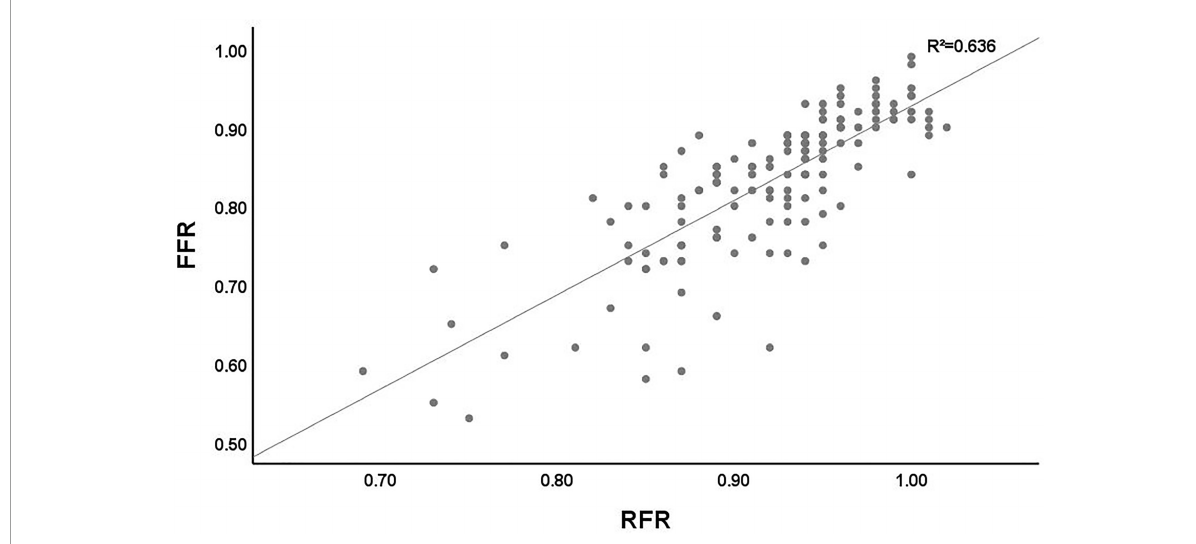
FIGURE1 Distribution of the lesions according the RFR and FFR. RFR, resting full-cycle ratio; FFR, fractional flow reserve.